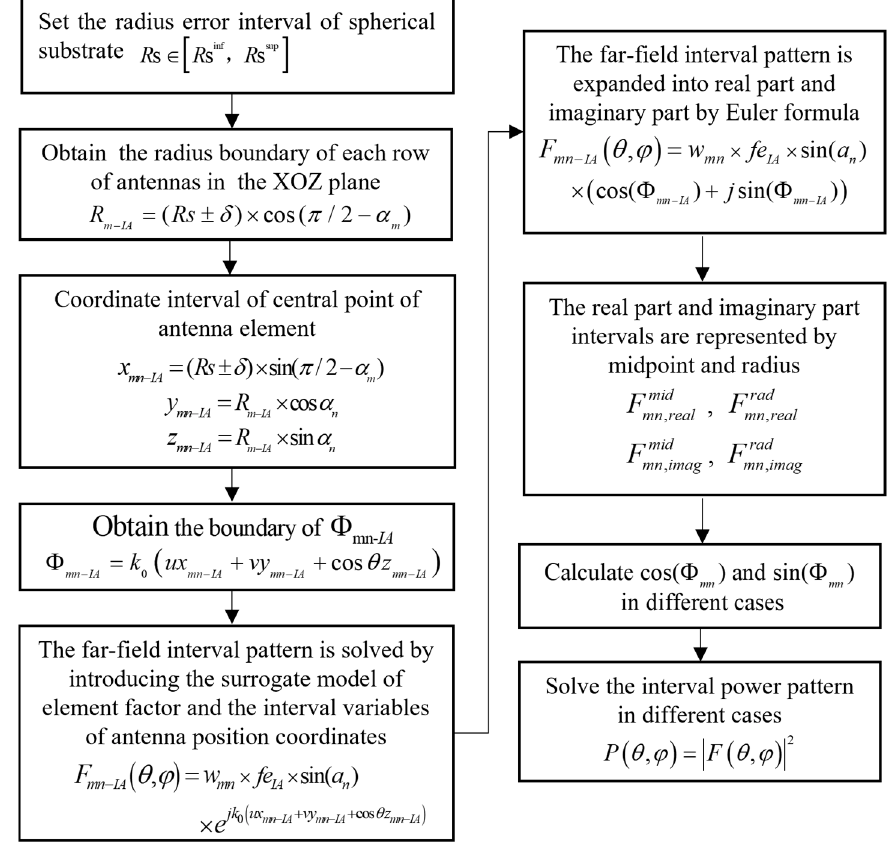
Figure 6. The flow chart for solving the interval power pattern.